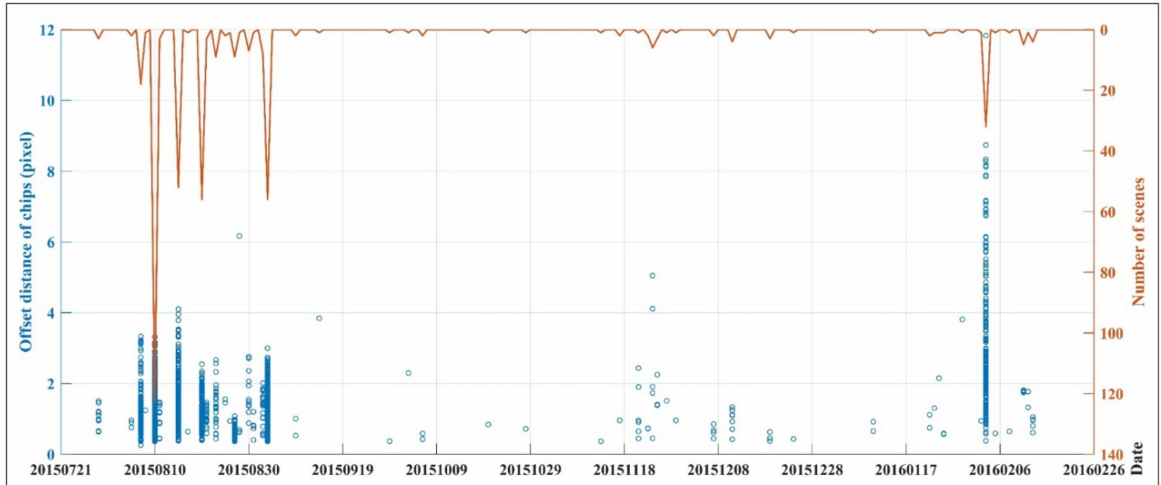
Figure 3. Temporal distribution of chips and scenes with an inter-band offset. The chips are represented with blue circles by the offset distance (pixel); the orange line represents the trend of scenes.